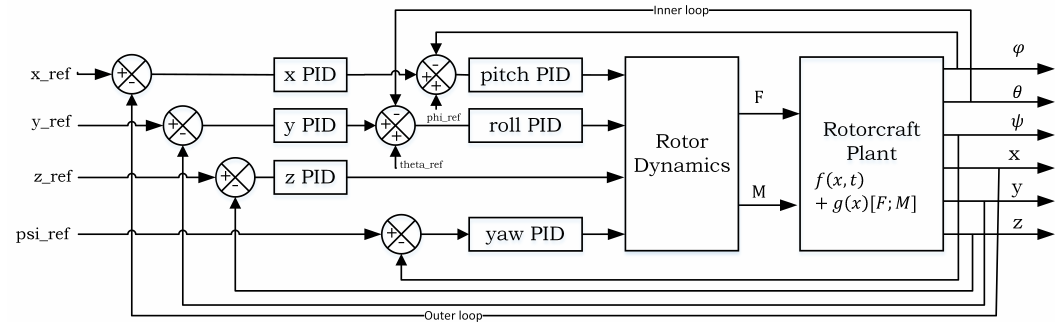
Figure 2. PID closed-loop system showing the inner loop for pitch( θ ) and roll( φ ), and the outer loop of x , y , z and yaw( ψ